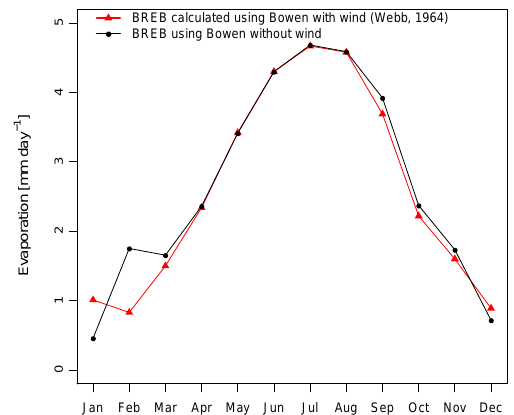
Figure B1. Monthly average of BREB evaporation computed with and without the effect of